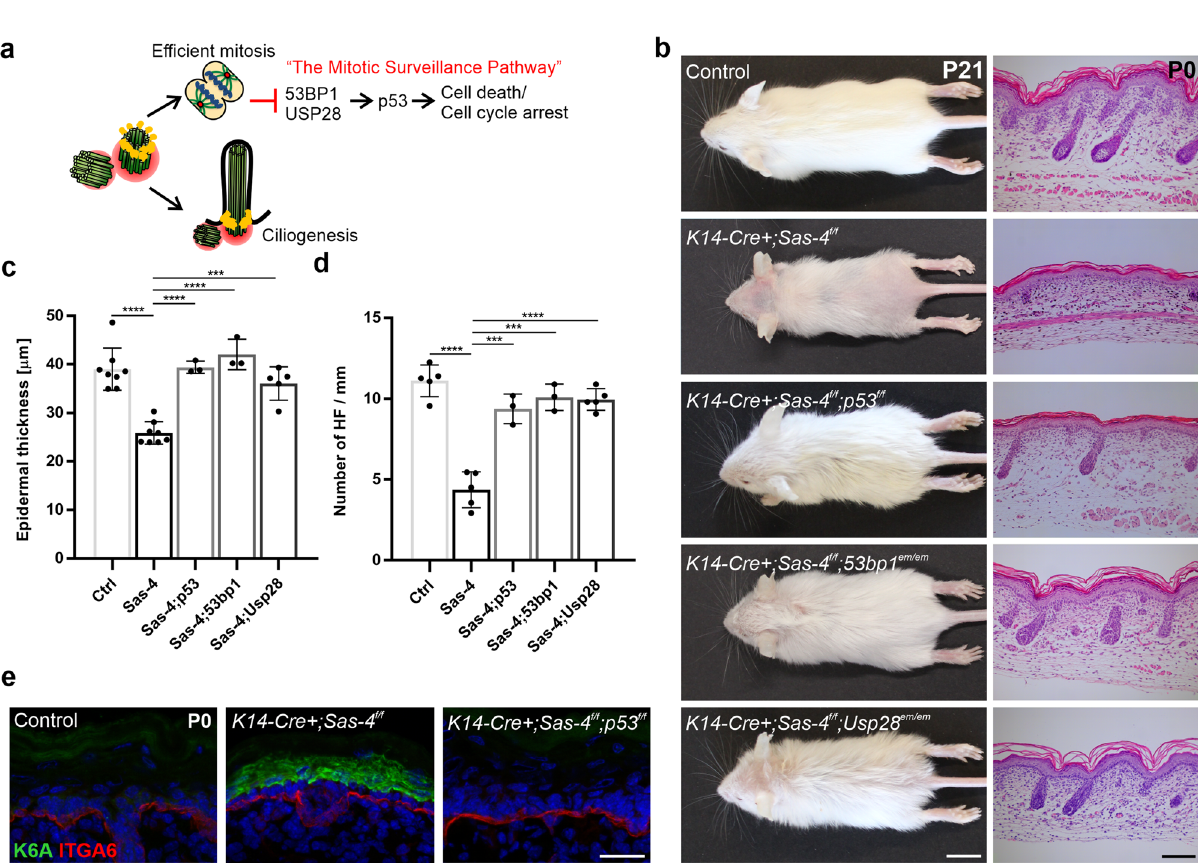
Fig. 3 The skin epidermal phenotypes in centrosome mutants are due to the activation of the mitotic surveillance pathway. a Centrioles, besides providing the essential template for cilia, ensure ef fi cient mitosis and repress the activation of the mitotic surveillance pathway: p53 stabilization mediated by 53BP1 and USP28 leading to cell death (mainly shown in vivo) or cell cycle arrest (mainly shown in vitro). b Gross phenotypes of Control, K14-Cre + ; Sas-4 f/f , K14-Cre + ; Sas-4 f/f ; p53 f/f ; K14-Cre + ; Sas-4 f/f ; 53bp1 em/em and K14-Cre + ; Sas-4 f/f ; Usp28 em/em mice are shown at P21 (scale bar: 1 cm), as well as H&E histological staining of back-skin sections at P0 (scale bar: 100 µ m). c Quanti fi cation of the interfollicular epidermal thickness ( c ), excluding the corni fi ed layer, at P0 of Control ( n = 8), K14-Cre + ; Sas-4 f/f ( n = 8), K14-Cre + ; Sas-4 f/f ; p53 f/f ( n = 3), K14-Cre + ; Sas-4 f/f ; 53bp1 em/em ( n = 3) and K14-Cre + ; Sas-4 f/f ; Usp28 em/em ( n = 5) mice. Control and K14-Cre + ; Sas-4 f/f animals are part of the same experiment in Fig. 1. d Quanti fi cation of the number of hair follicles at P0 of Control ( n = 5), K14-Cre + ; Sas-4 f/f ( n = 5), K14-Cre + ; Sas-4 f/f ; p53 f/f ( n = 3), K14-Cre + ; Sas-4 f/f ; 53bp1 em/em ( n = 3) and K14-Cre + ; Sas-4 f/f ; Usp28 em/em ( n = 5) mice. c , d *** p < 0.001, **** p < 0.0001 (two-tailed student ’ s T -test or one-way ANOVA and Tukey ’ s multiple comparisons test without adjustments). Bars represent mean ± SD. e Immunostaining of Control, K14-Cre + ; Sas-4 f/f and K14-Cre + ; Sas-4 f/f ; p53 f/f back-skin sections at P0 for K6A (green) and ITGA6 (red) (scale bar: 25 µ similar to the Sas-4 p53 double mutants, establishing their suggesting that they were likely to be hypomorphic alleles. essential role in the p53-dependent pathway in vivo (Fig. 3b – d). Consistent with the variable nature of hypomorphic mutations, These rescues were quite signi fi cant even though our CRISPR/ p53 nuclear levels only signi fi cantly decreased in the Sas-4 Cas9-generated mutations in Usp28 and 53bp1 had residual 53bp1 double mutants compared to the Sas-4 single mutants proteins by immunostaining (Supplementary Fig. 3a, b), (Supplementary Fig. 3d).